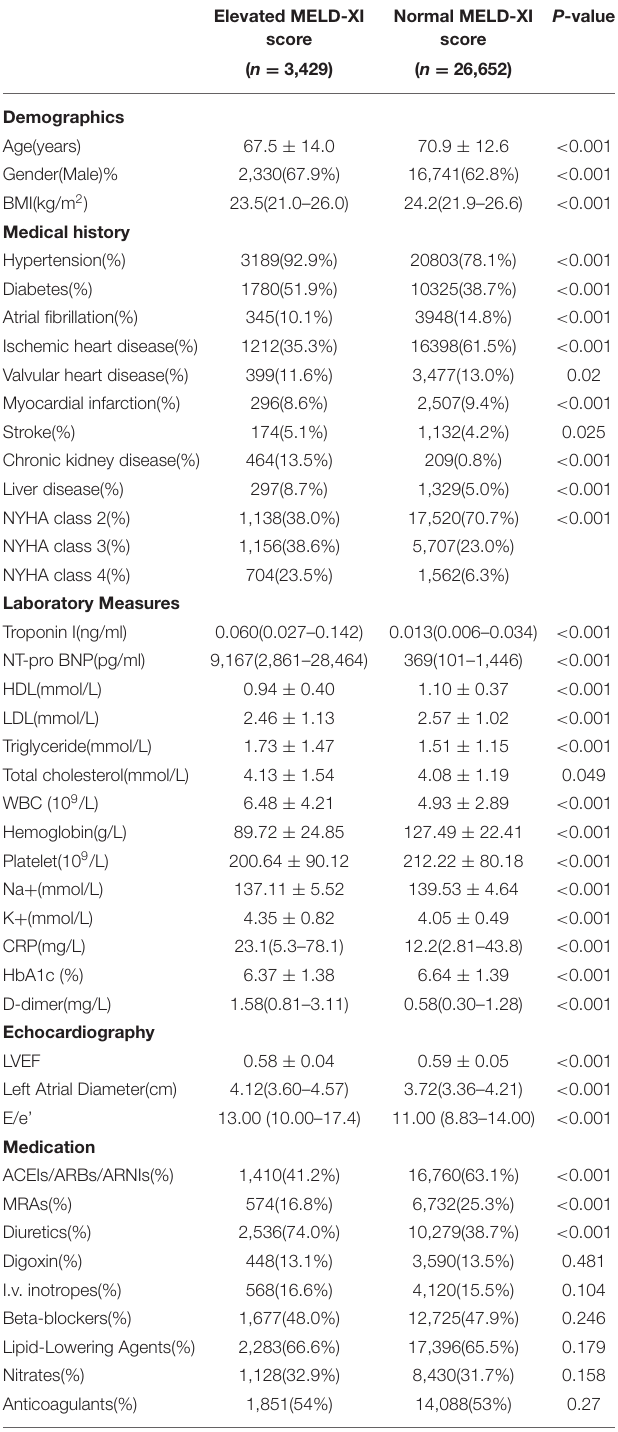
TABLE 1 | Baseline characteristics between patients with elevated and normal MELD-XI